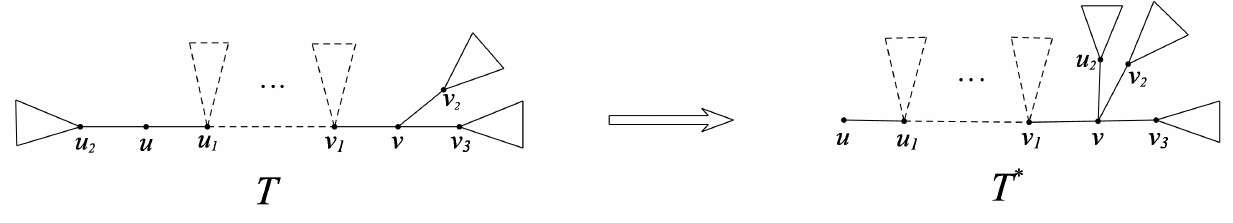
Figure 4: Transformation C used in Lemma